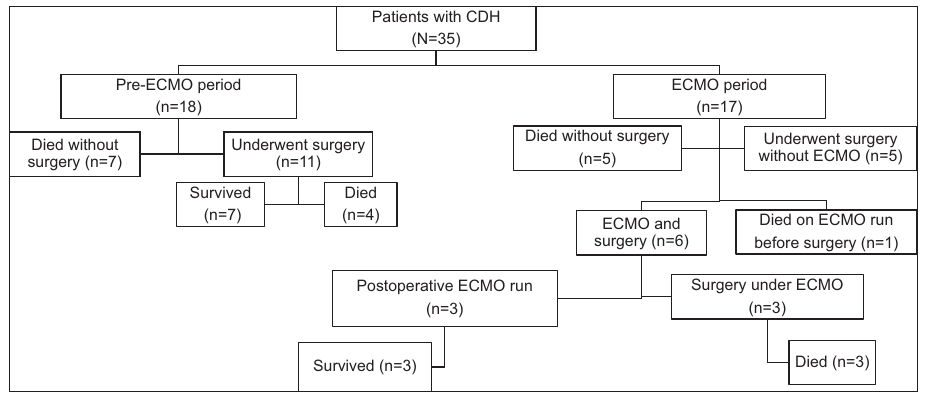
Figure 1: Patients with congenital diaphragmatic hernia who were admitted to our neonatal intensive care unit during the study periods. CDH: Congenital diaphragmatic hernia, ECMO: Extracorporeal membrane